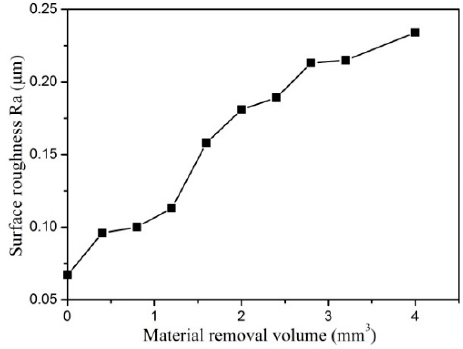
Figure 14. The effect of material removal volume on surface roughness.